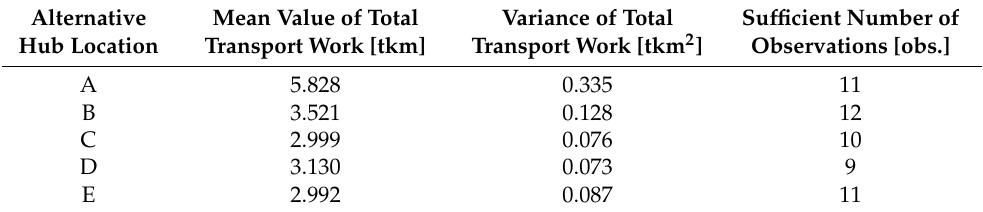
Table 2. Results of computer simulations for the considered loading hub locations.